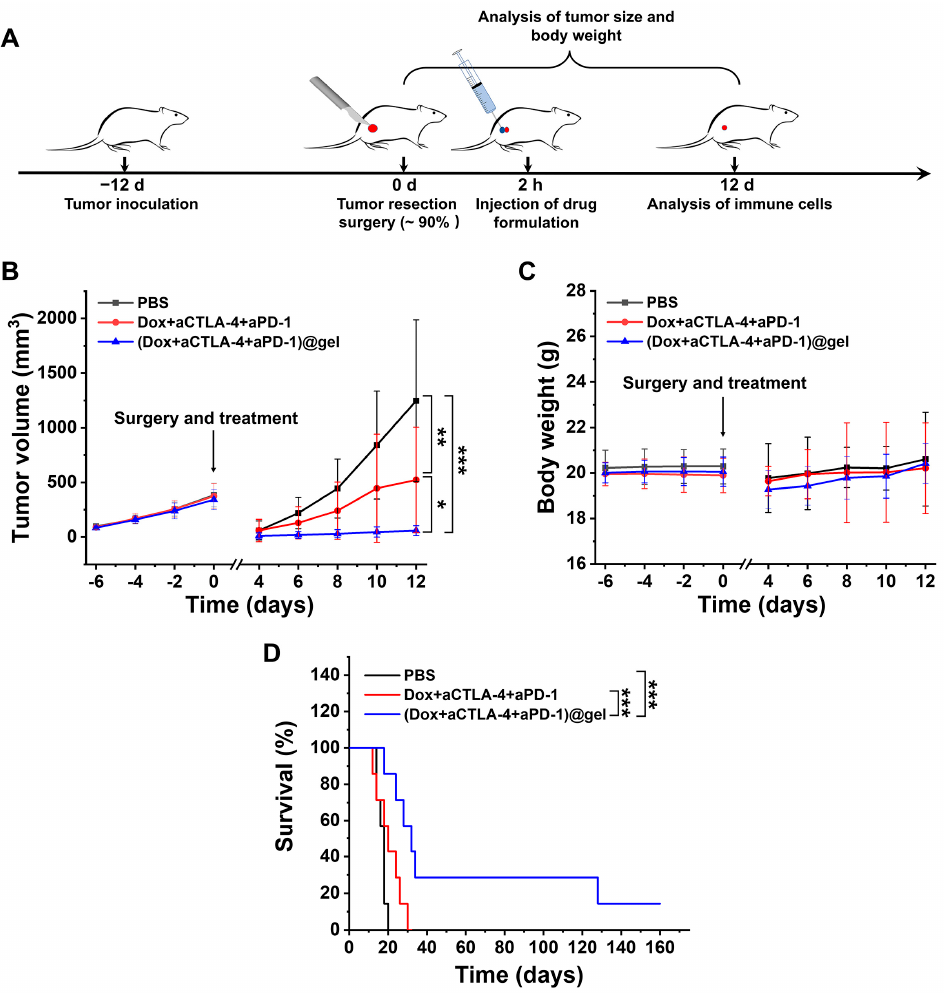
Figure 7. ( A ) Schematic illustration of post-surgical treatment by the injection of drug-containing systems to the surgical site after ~90% tumor resection. ( B ) Tumor volume curves during treatment ( n = 12). ( C ) Changes of the body weight of mice during treatment ( n = 12). ( D ) Survival periods of various groups after treatment ( n = 7). (* p < 0.05, ** p < 0.01, and *** p <